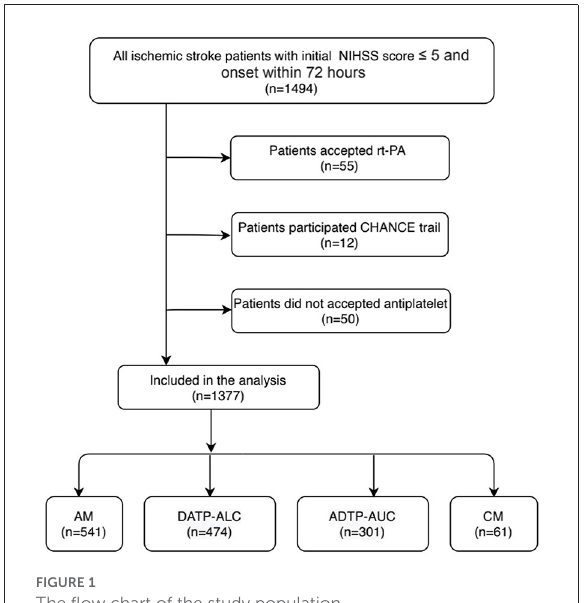
FIGURE1 The flow chart of the study